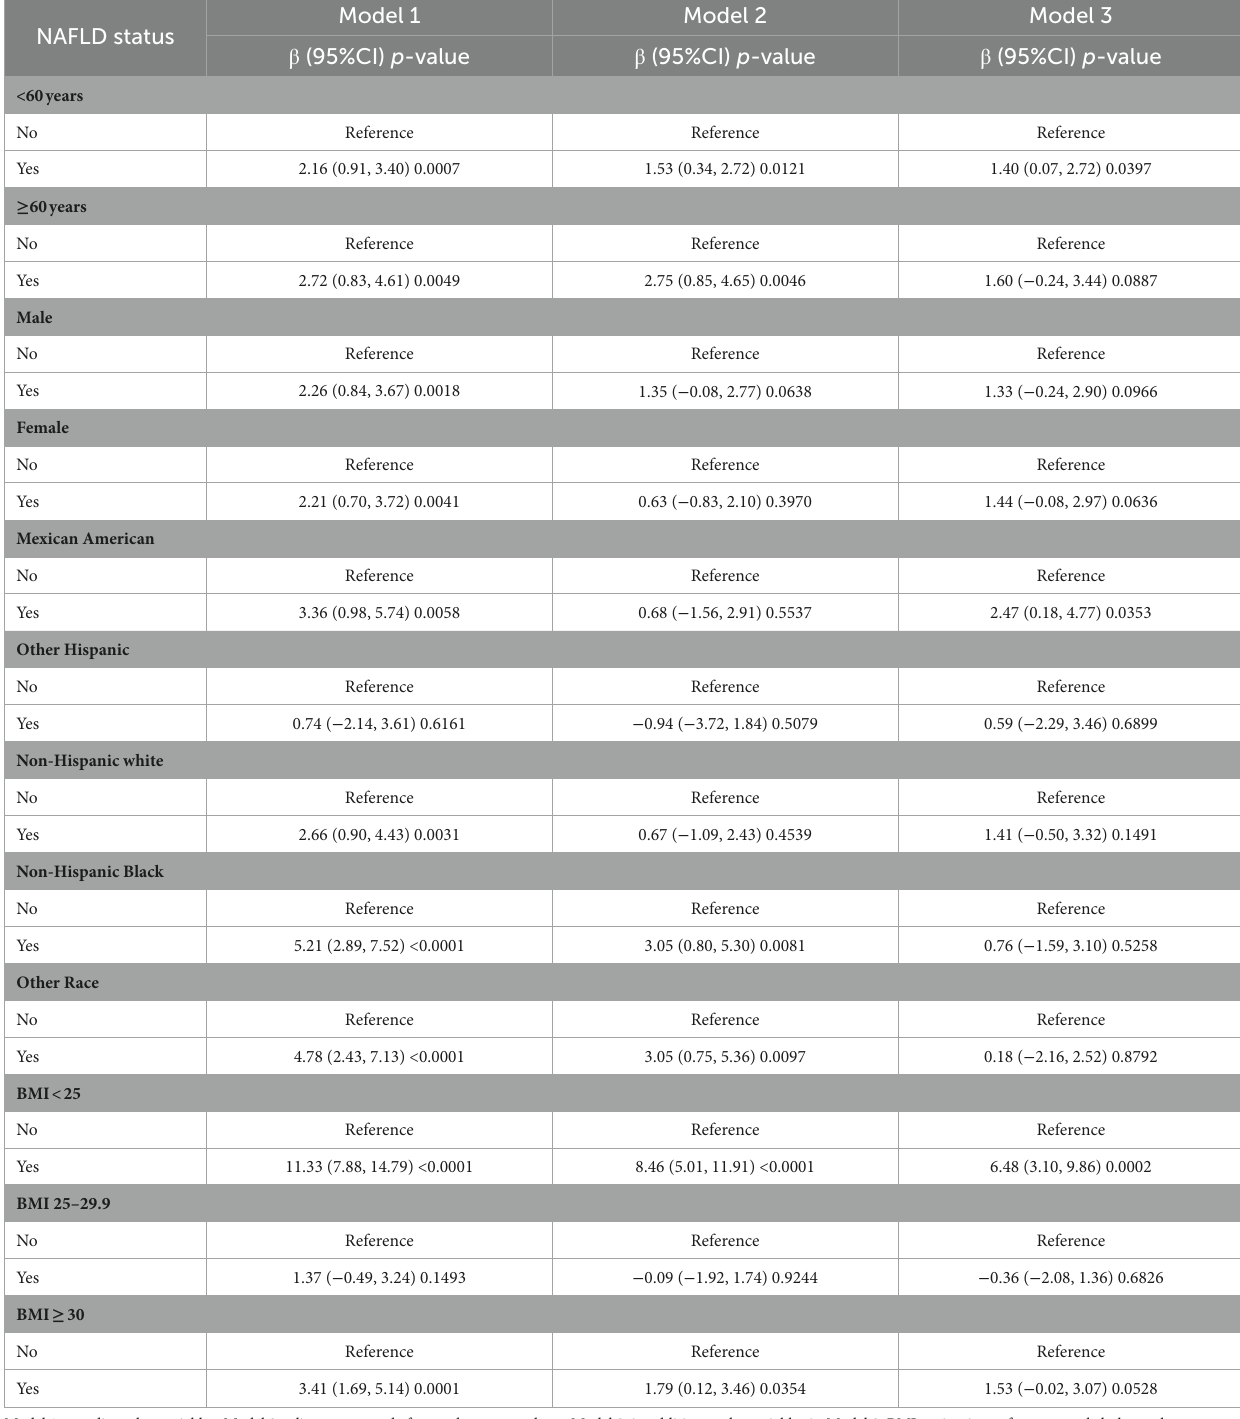
Model 1, no adjusted covariables; Model 2, adjustments made for gender, race, and age; Model 3, in addition to the variables in Model 2, BMI, waist circumference, total cholesterol, triglyceride, ALT, AST, GGT, total bilirubin, serum albumin, serum creatinine, blood urea nitrogen, recreational physical activity, smoking status, and diabetes were added. In different stratified policies, stratified variables were not adjusted